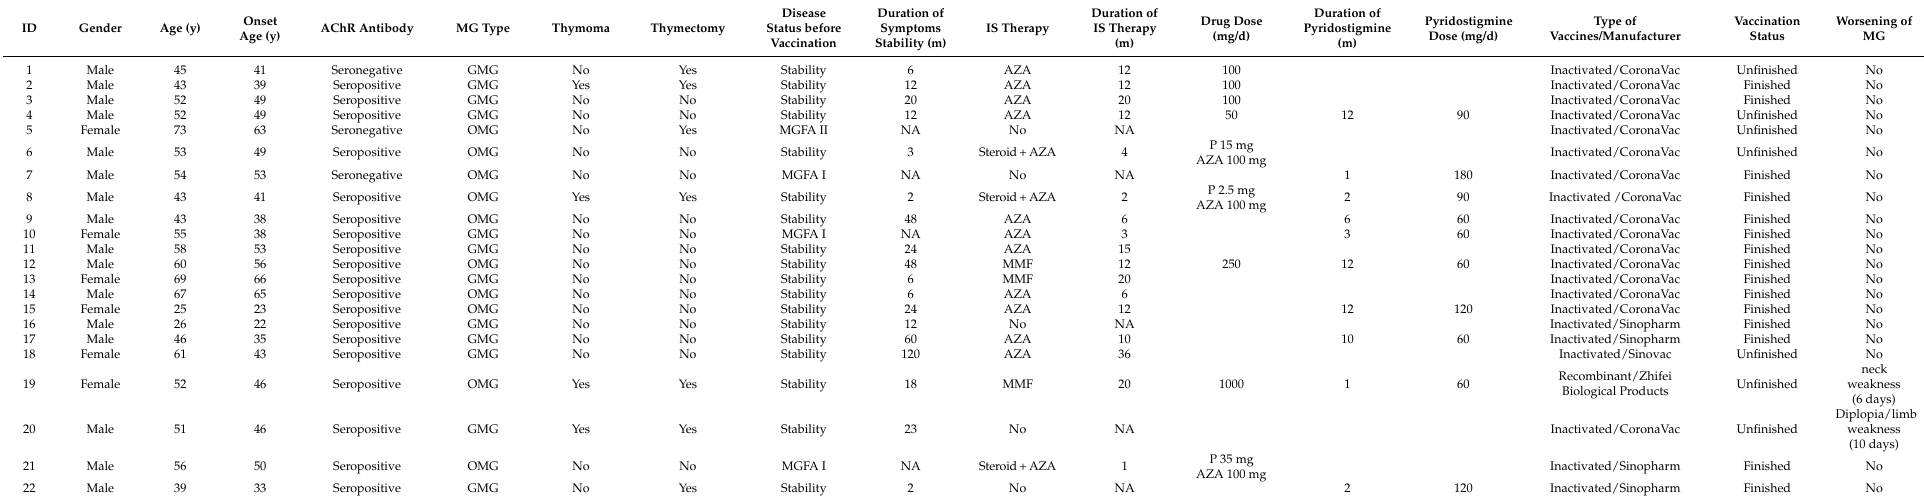
Table 2. Clinical features of individual